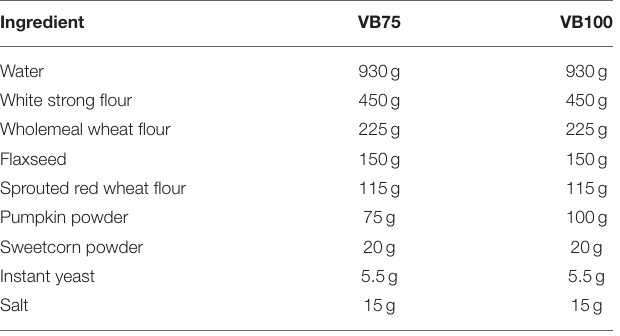
TABLE 2 | Proximate composition of